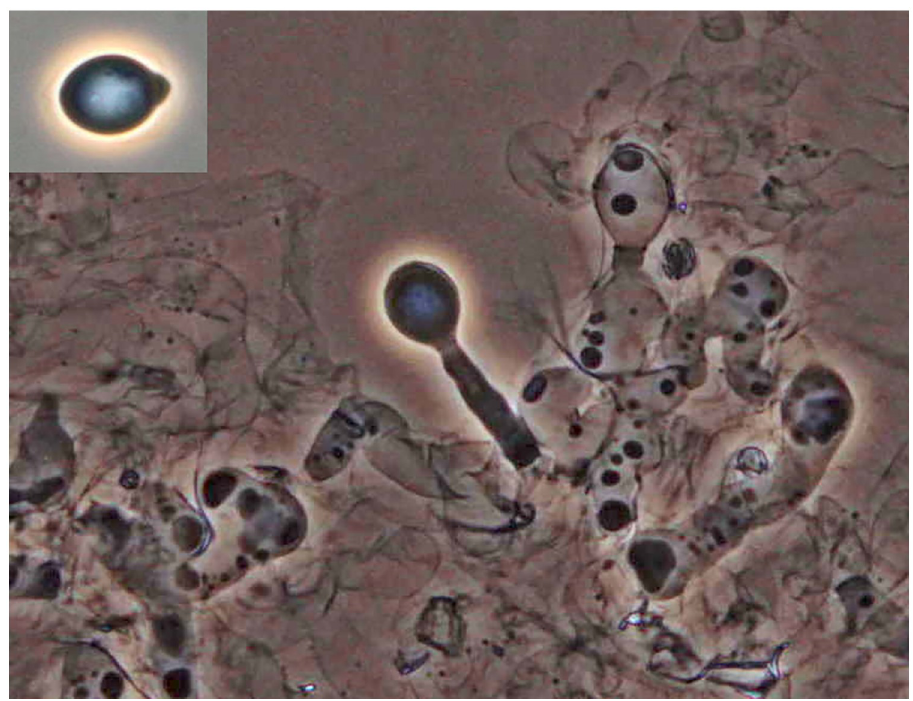
Fig 1. The mycelium of Pandora sp. from Cacopsylla sp. with a primary conidium on top of a conidiophore and a discharged primary conidium (insert in upper left corner). The length of conidia of Pandora sp. is 15.6-23.3 μ m [8].